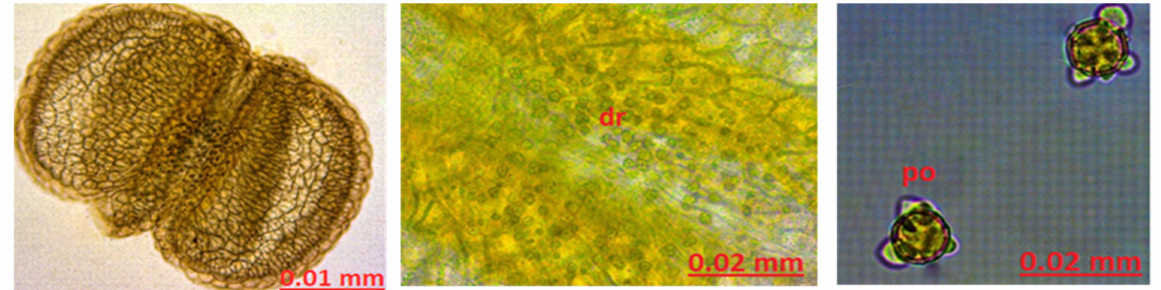
Figure 6. The stamen anatomy of Hypericum scabrum ; dr: druse, po: pollen. Sepal Anatomy: When the sepal structure was examined, glandular growths, which are important in terms of diagnosis, were observed. Secretory growths vary in number between 12 and 16 at the apex and on both sides of the apex. The secretion is ovalized and enlarged toward the top of the growths, and its color varies between yellow and orange. Between the veins on the surface of the sepal, there are a large number of round secretory structures of bright yellow color. A large amount of starch stained blue with Sartur reagent was found around the sepal. Sclerenchyma structure was observed (Figure 7).